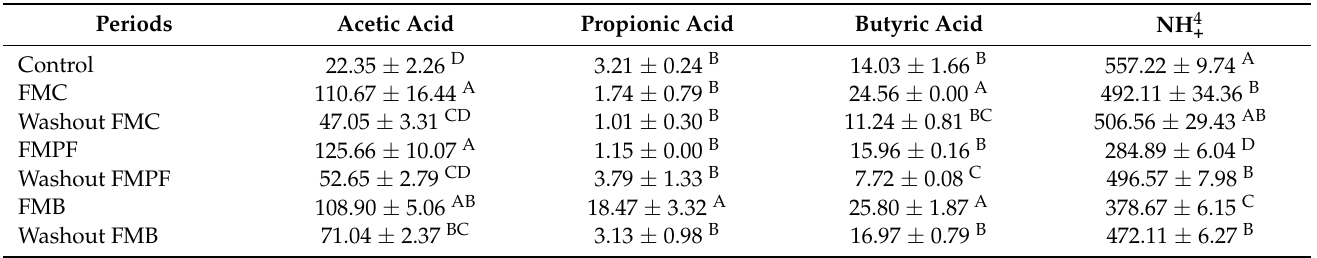
Table 3. Short-chain fatty acid levels and ammonium ion (mmol/L) in the vessels corresponding to the ascending colon during the experimental